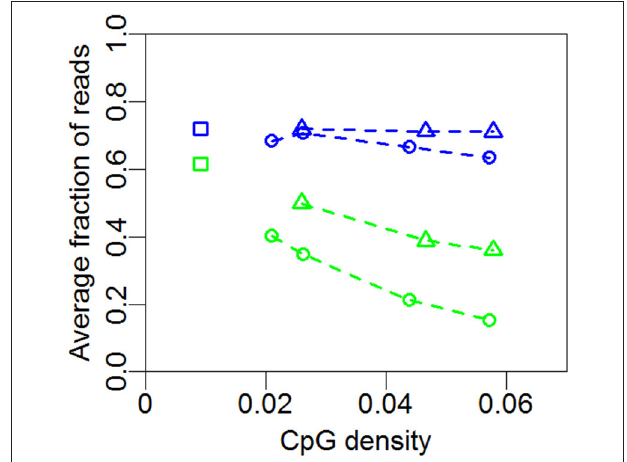
FIGURE 4 | Mean nucleosome occupancy and mean methylation. Mean methylation (green) and mean nucleosome occupancy (blue) of the profiles in Figures 1, 2 and 3A for promoter (circles) and non-promoter regions (triangles). Each point represents the mean methylation or nucleosome occupancy of a given profile in Figures 1, 2 or 3A . Squares represent whole-genome